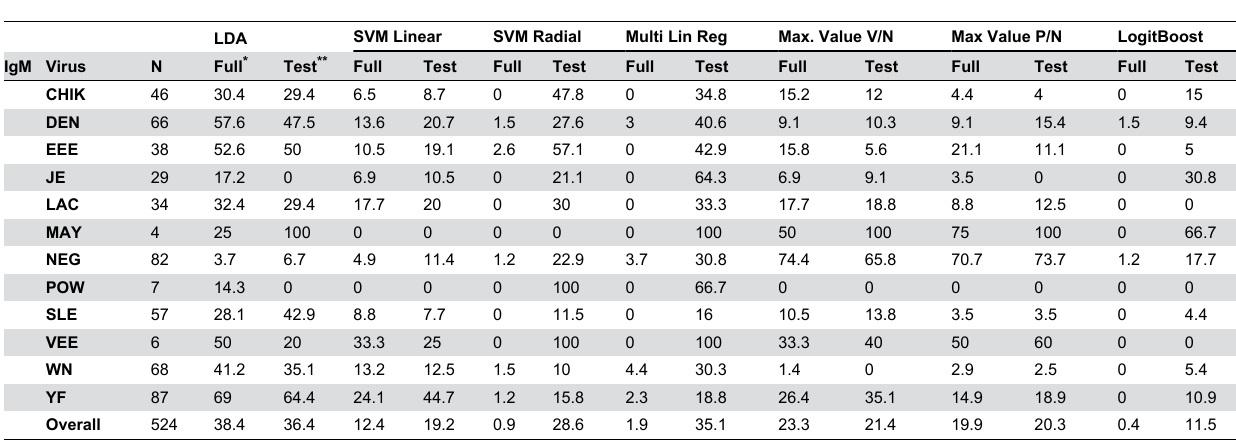
Table 4. IgM multiplex MIA error rates (%) for each virus based on initial serum set.